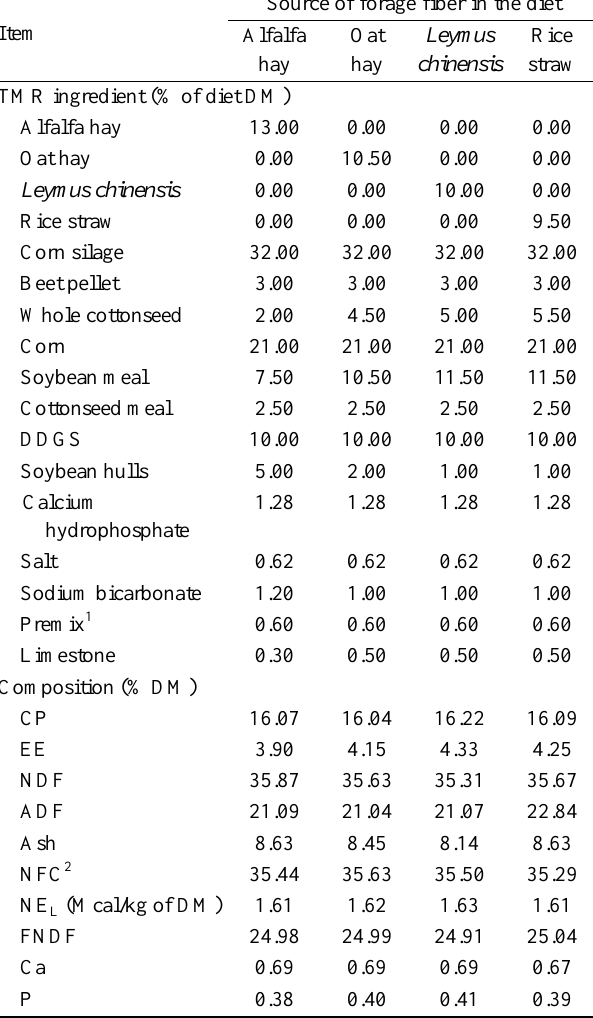
Table 1. Ingredient composition and chemical analysis of experimental TMR diets fed to lactating dairy cows Source of forage fiber in the Item